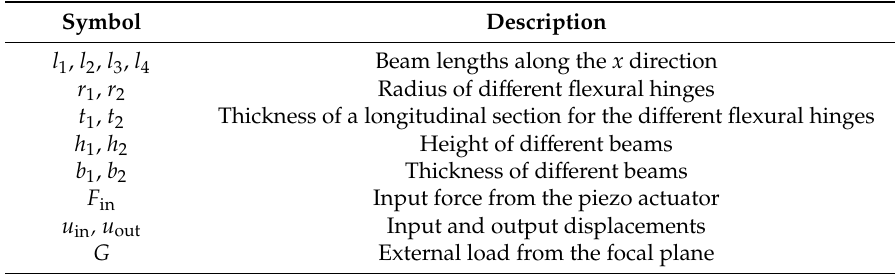
Table 1. Symbols used in the calculation